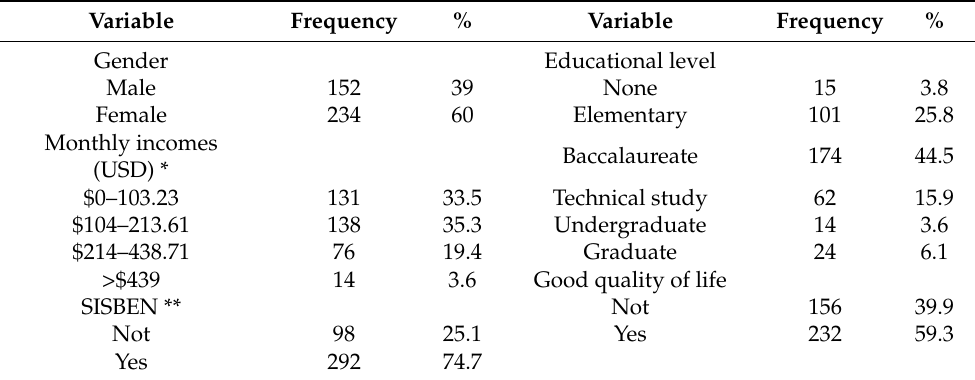
Table 1. General socio-economic information.